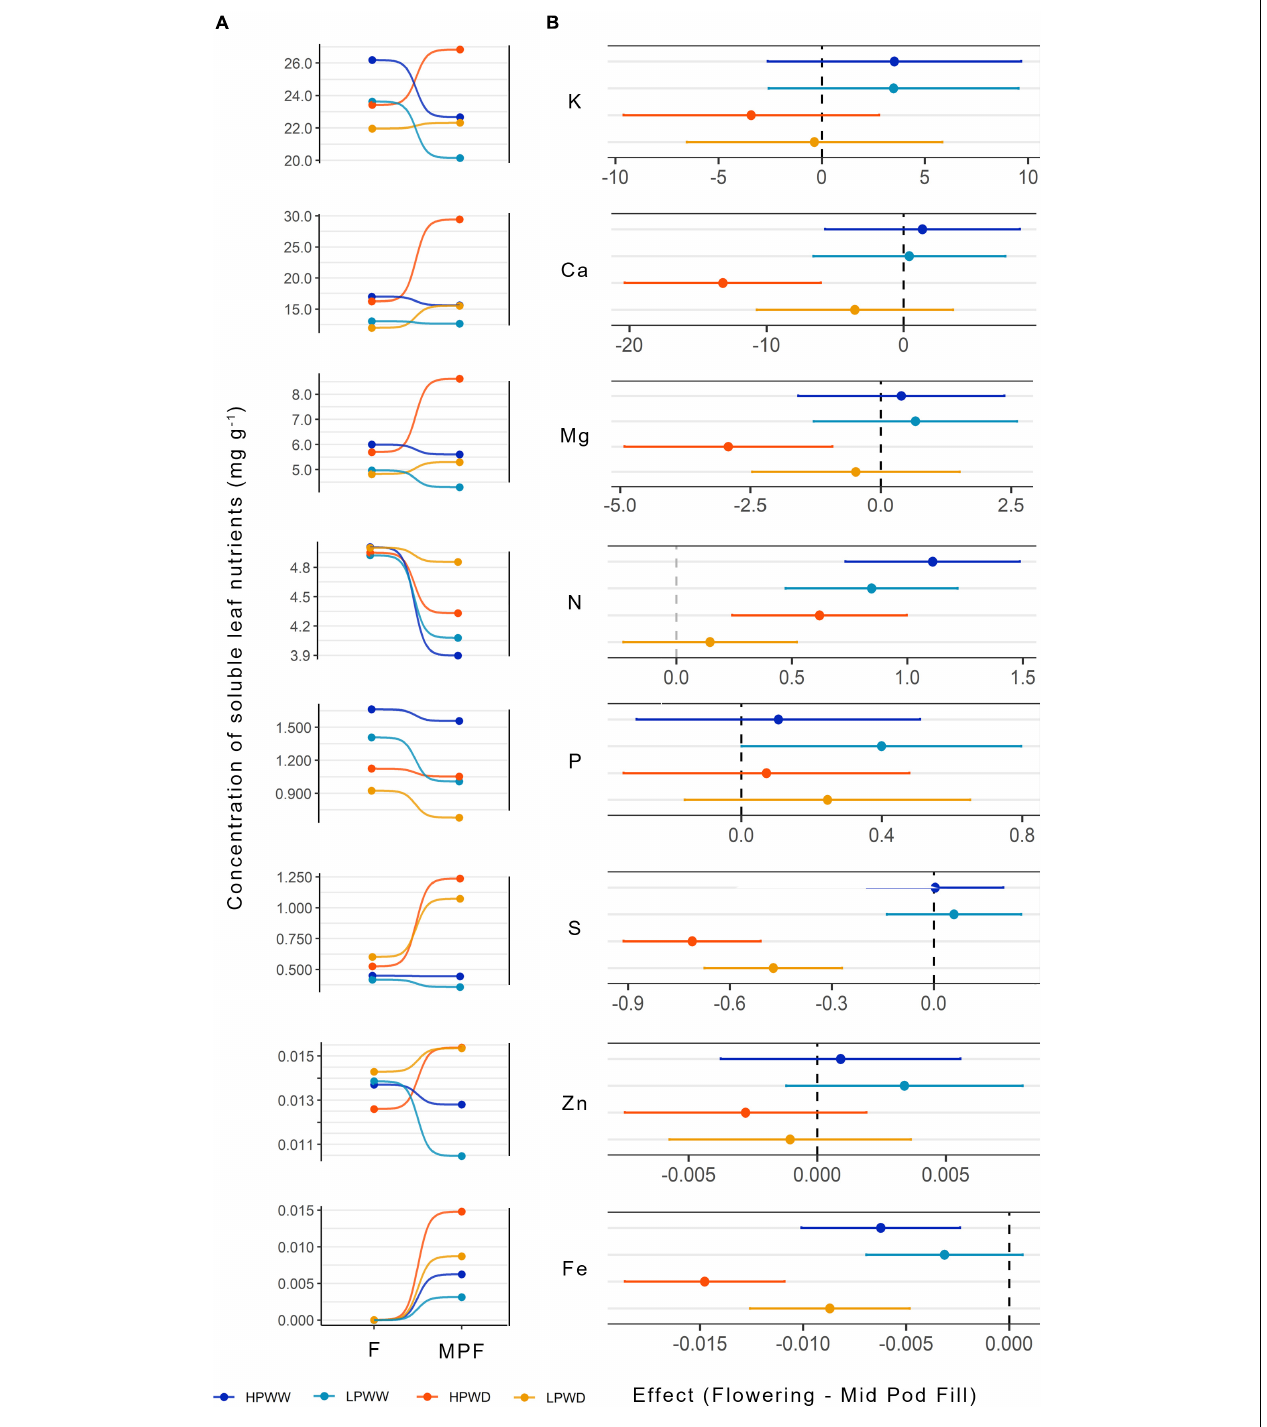
FIGURE 5 | (A) Concentration (mg/g) of soluble leaf nutrients for 12 common bean lines under treatments of high phosphorus well-watered (HPWW; blue) low phosphorus well-watered (LPWW; light blue), high phosphorus water deficit (HPWD; orange), and low phosphorus water deficit (LPWD; yellow-orange) at flowering (F) and mid-pod fill (MPF) stage. (B) Effect of development stage (flowering—mid-pod fill) on the concentration of nutrients at different treatments. Dots represent mean value with upper and lower confidence level; x-axis shows the mean difference in the concentration of nutrients at four treatments; vertical dash lines illustrate 0 effect, where values close to 0 are not significantly different according to the HSD test at A = 0.05. For visualization purposes, only four treatments are shown; the complete list of multiple treatments and stage comparisons is provided in Supplementary Table 7 .